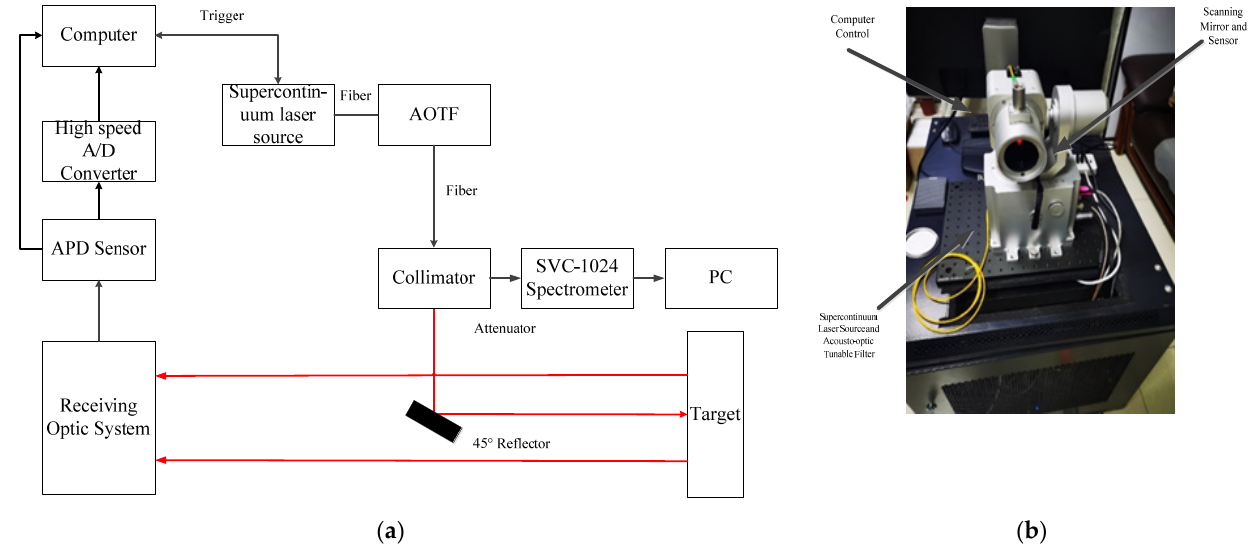
Figure 1. ( a ) Architecture of HSL system. ( b ) Prototype of AOTF-HSL.